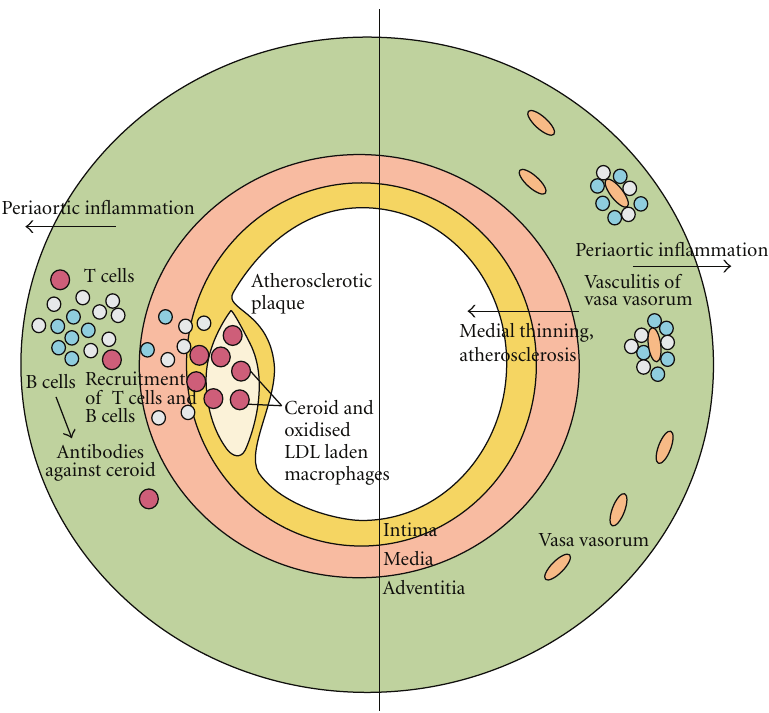
Figure 5: Two potential pathogenetic mechanisms of chronic periaortitis [1].